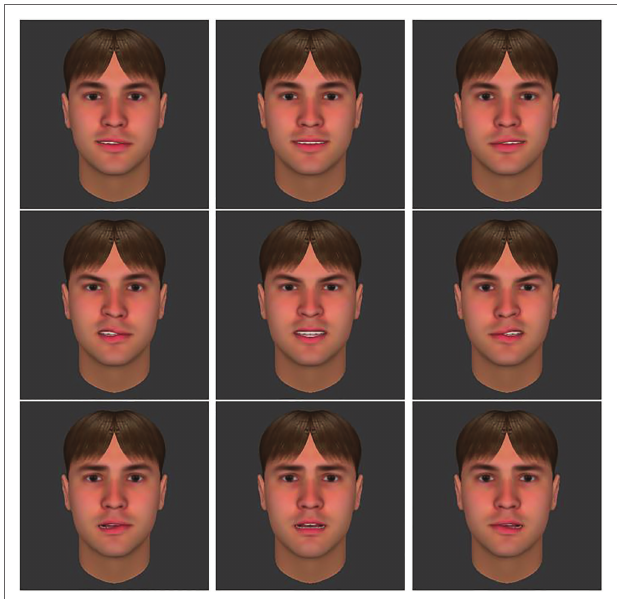
FIGURE 1 | Illustration of the three (a)symmetries (respectively left hemiface, symmetry, and right hemiface) of each emotion (respectively happiness, anger, and fear) for the young